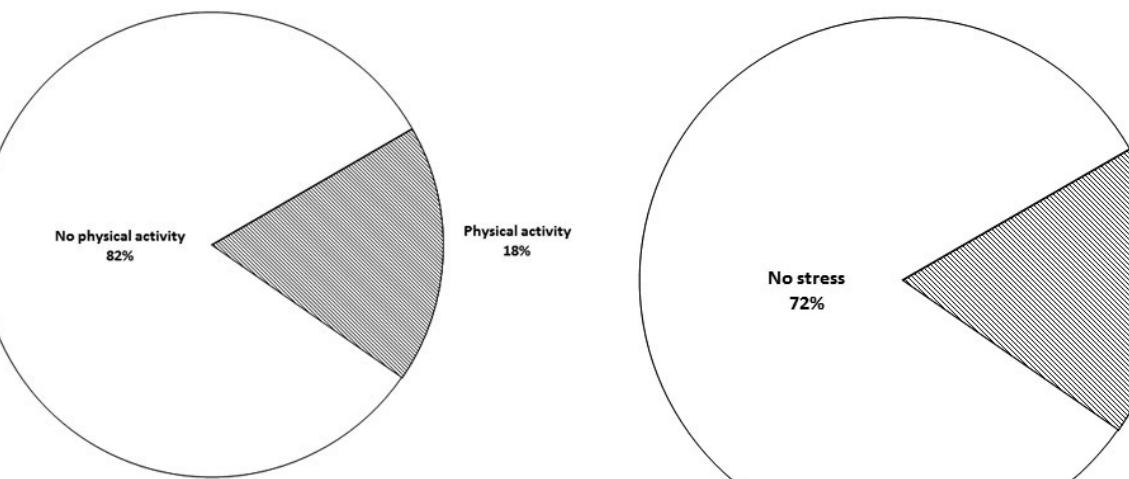
Fig. 2 - Graphic showing that 82.1% of the sample were sedentary and only 17.9% practice physical exercises regularly.